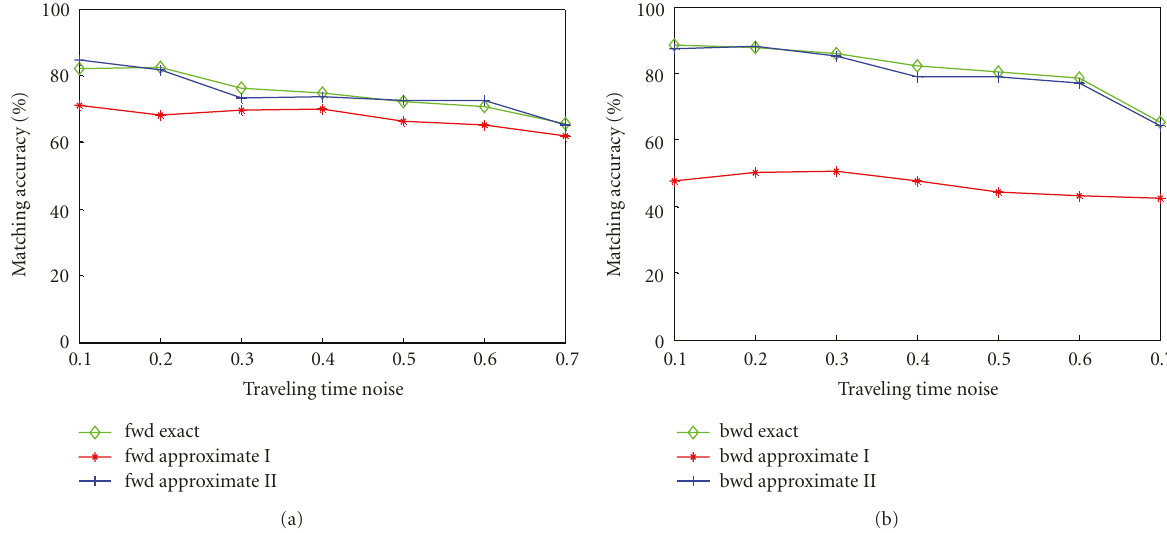
Figure 10: Mean accuracy under di ff erent level of traveling time standard deviation. X -axis corresponds to the ratio of standard deviation to mean value of the traveling time observations. (a) Forward inference. (b) Backward